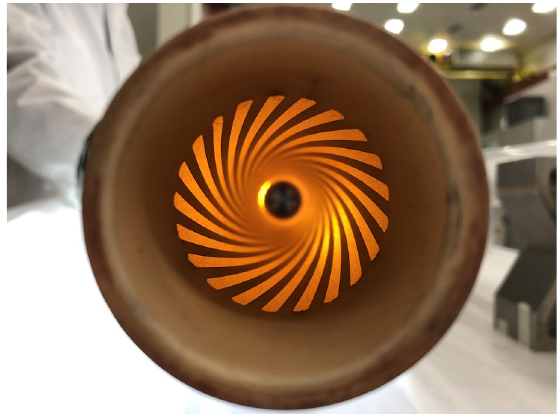
FIG. 18. Photograph of the prototype helical beam screen with 21 screen conductors applied using vacuum compatible Ag paint and ∼ 4 . 5 turns along the length of the alumina